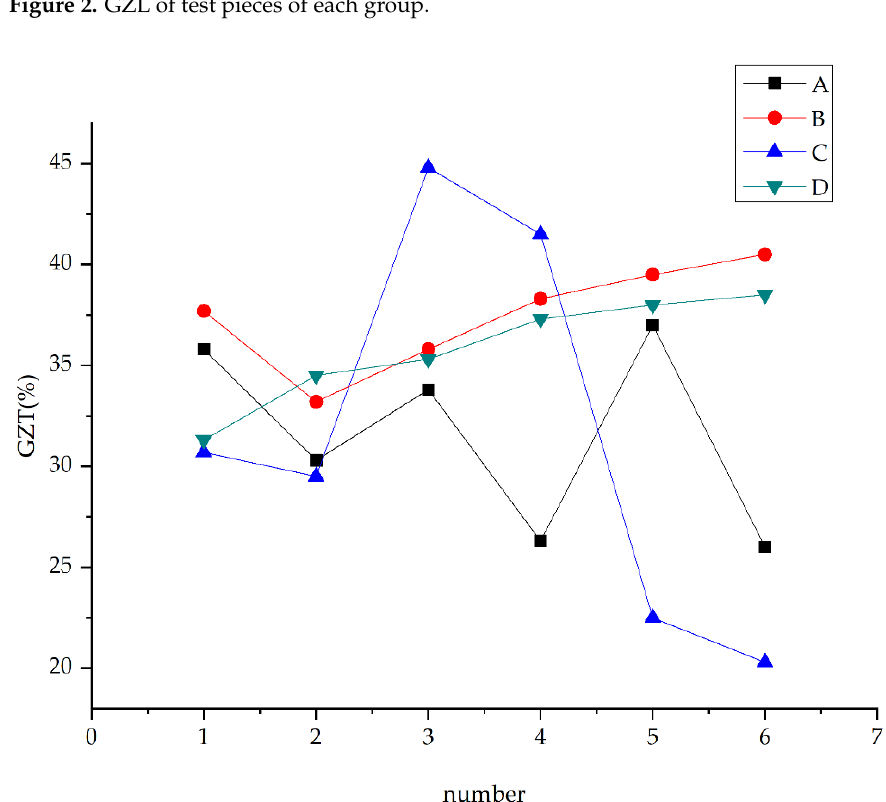
Figure 3. GZT of test pieces of each group.